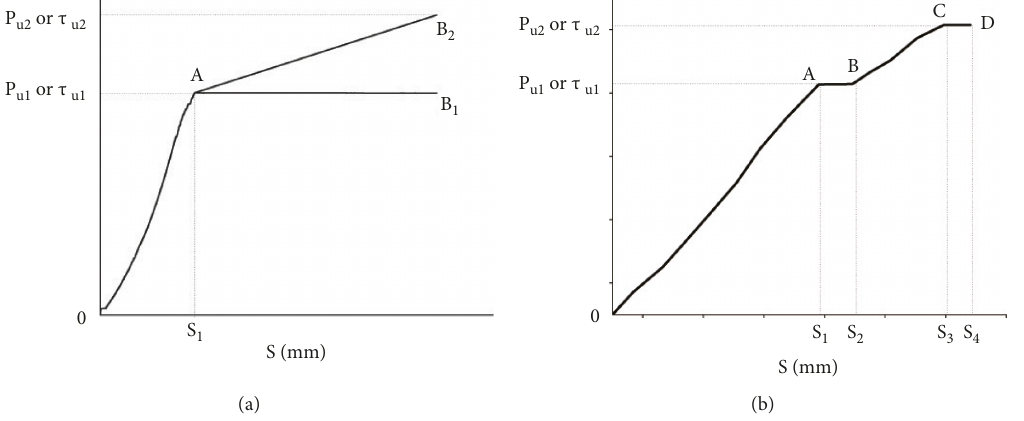
Figure 6: Bond-slip test results with error bars.